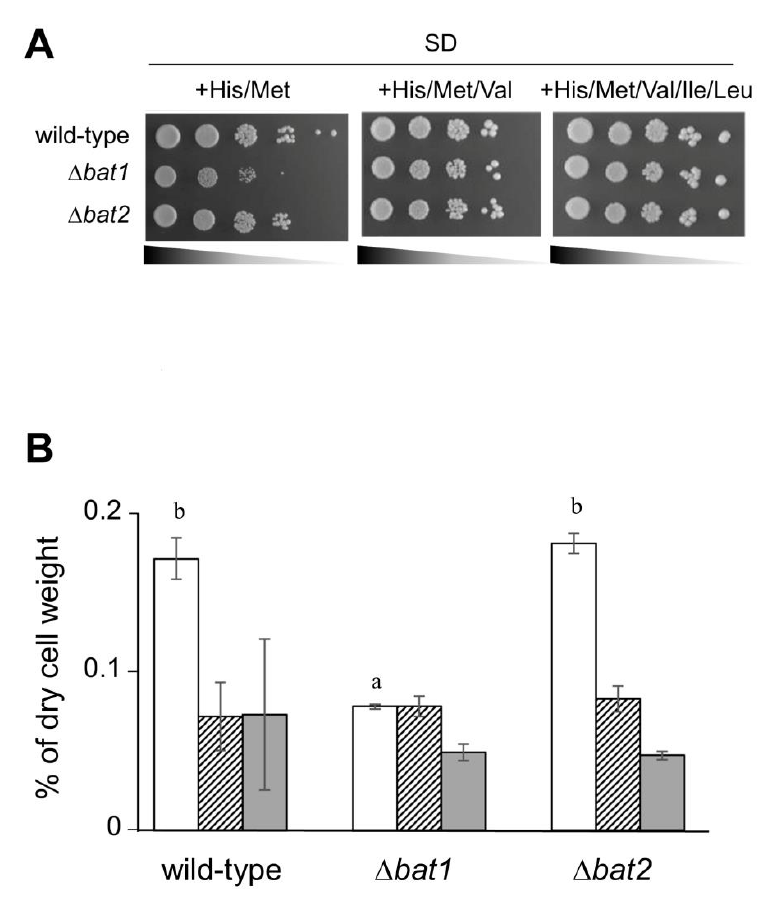
FIGURE 1: Effects of Bat1 and Bat2 on the growth and BCAAs contents of yeast cells. (A) Growth phenotypes of S. cerevisiae wild-type (BY4741), ∆ bat1 , and ∆ bat2 cells harboring pRS415/pRS416 cultured on SD+His/Met, SD+His/Met/Val or SD+His/Met/Val//Ile/Leu medium. (B) Intracellular BCAAs contents of S. cerevisiae wild-type (BY4741), ∆ bat1 , and ∆ bat2 cells harboring pRS415/pRS416 cultured in SD+His/Met medium. White, striped, and dark gray bars represent intracellular valine, leucine, and isoleucine contents, respectively. The values are the means and standard devia- tions of three independent experiments. Sta- tistically significant differences were deter- mined by Student’s t test ( a,b p